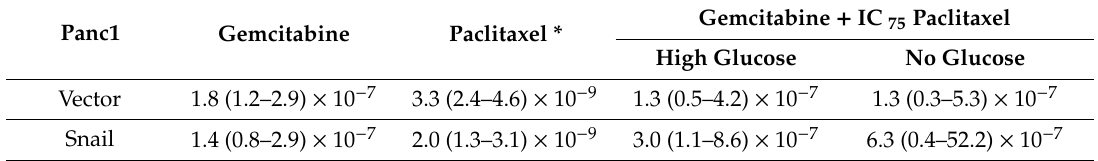
Table 1. The half-maximal inhibitory concentration (IC 50 ) of gemcitabine, paclitaxel and combination gemcitabine with an IC 75 dose of paclitaxel in vector control and Snail overexpressing Panc1 cells. Combination treatment was given under both high and no glucose media conditions.